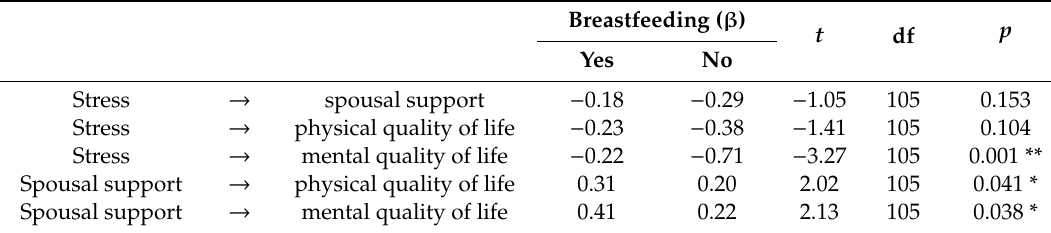
Table 6. Multiple group analysis results by breastfeeding experience (moderating e ff ect).